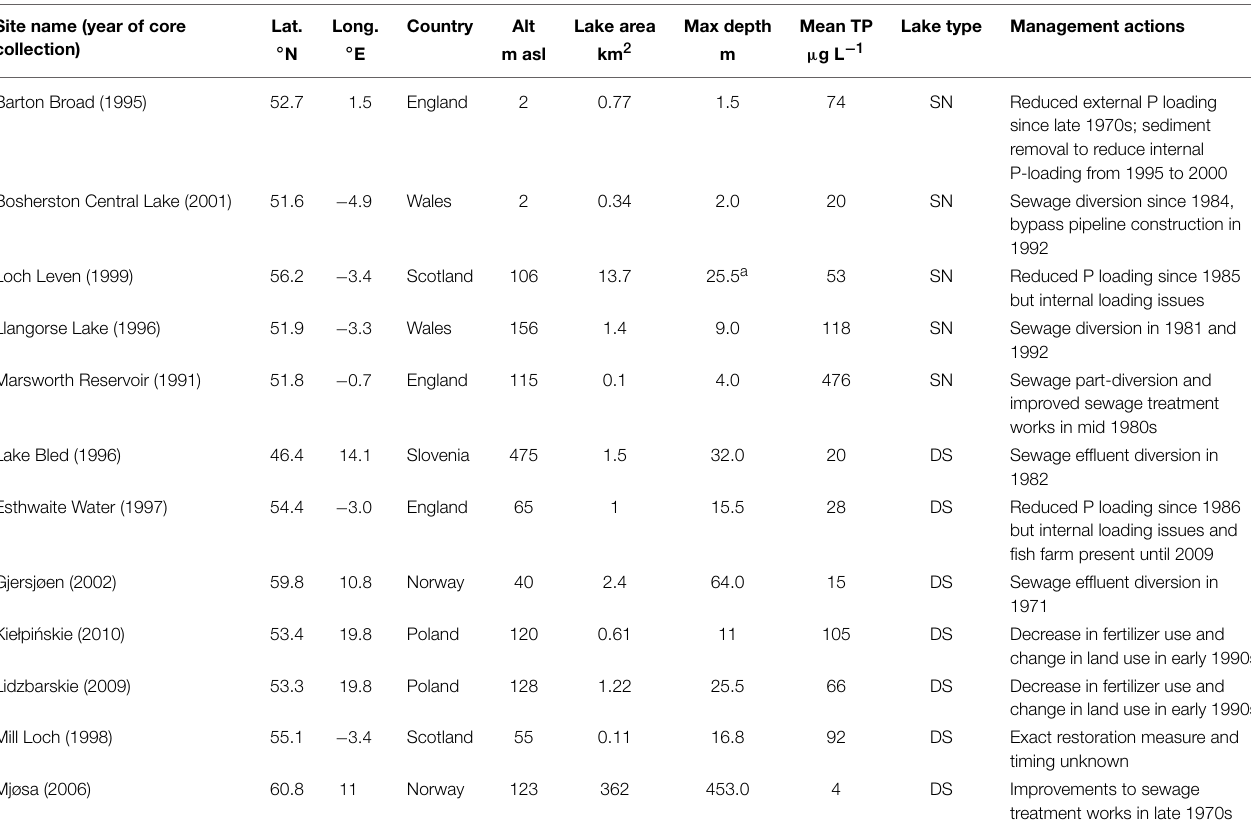
TABLE 1 | Summary characteristics of the 12 study